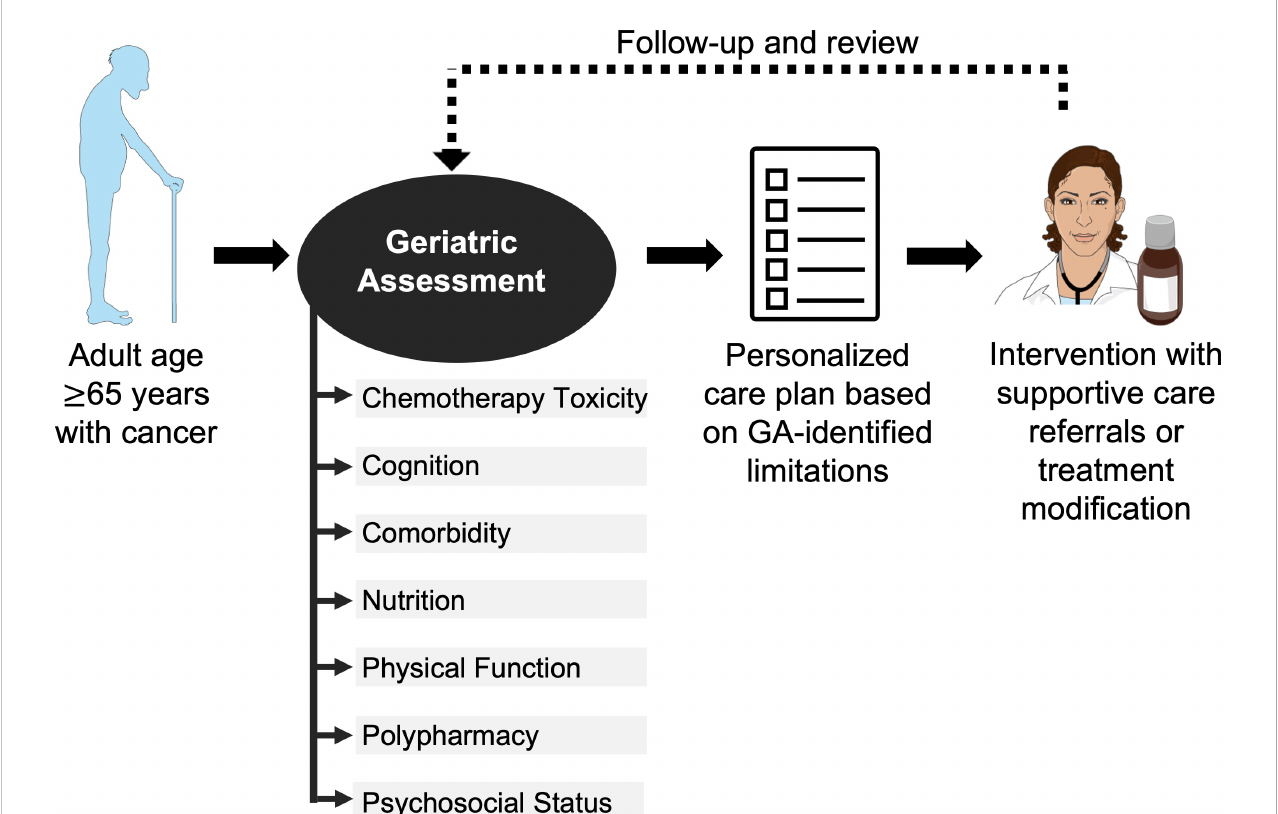
FIGURE 1 Use of geriatric assessment in management of older adult with cancer. The American Society of Clinical Oncology recommends all adults with cancer ≥ 65 years starting chemotherapy undergo a geriatric assessment of multiple domains to guide management. The Figure was partly generated